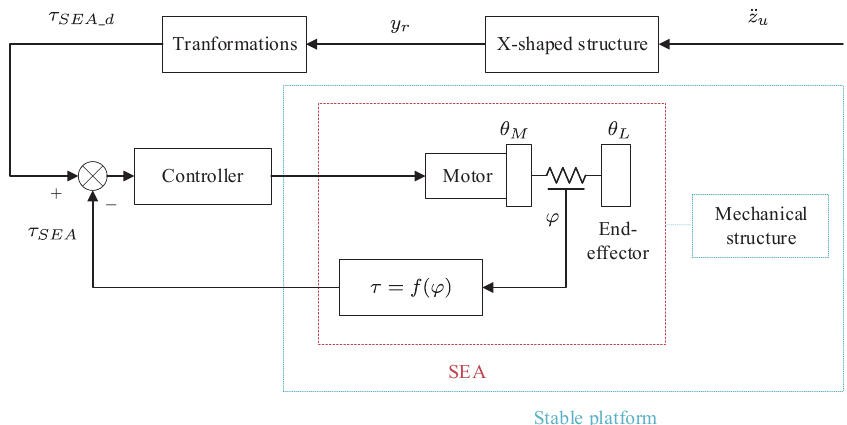
Figure 1. Control block diagram of the stable platform with the SEA based on the X-shaped structure.